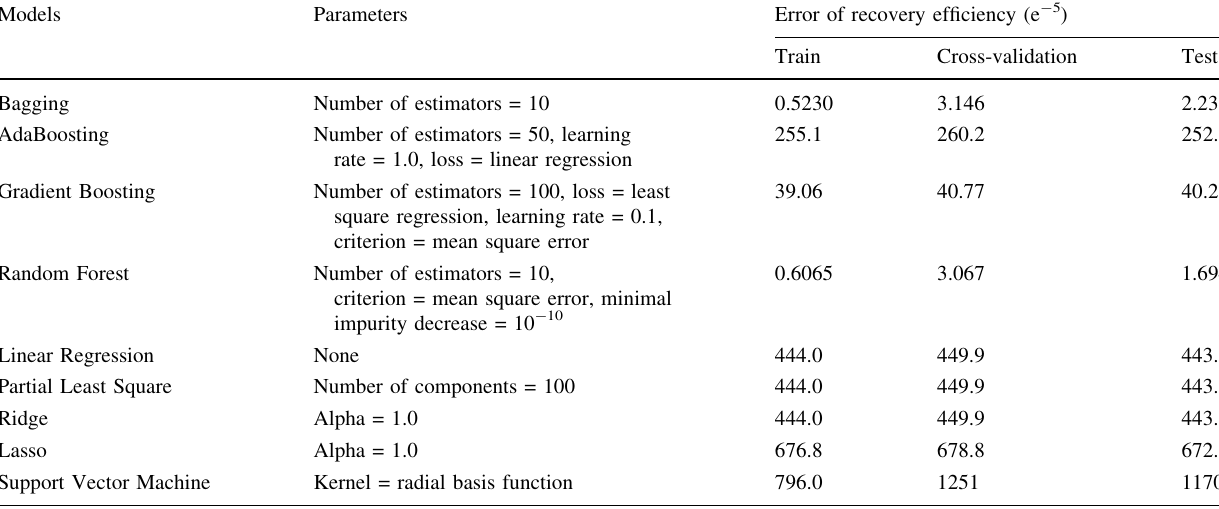
Table 5 Comparison among different machine learning models Models